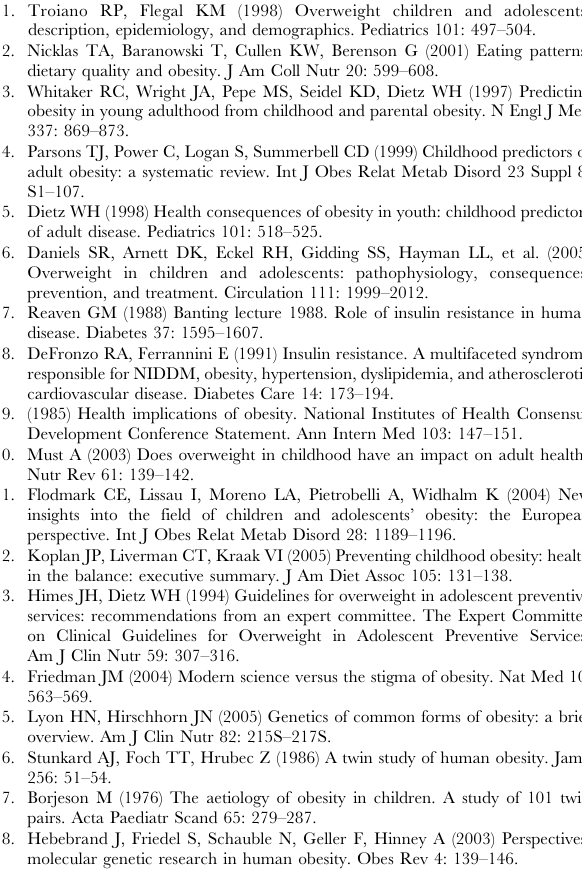
Table S2 Quantitative analysis of BMI results for FTO region markers